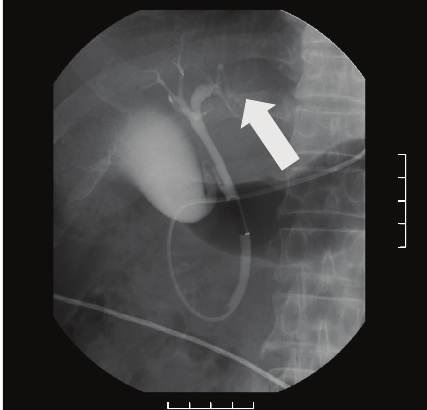
Figure 2: ERC revealed a filling defect within B3